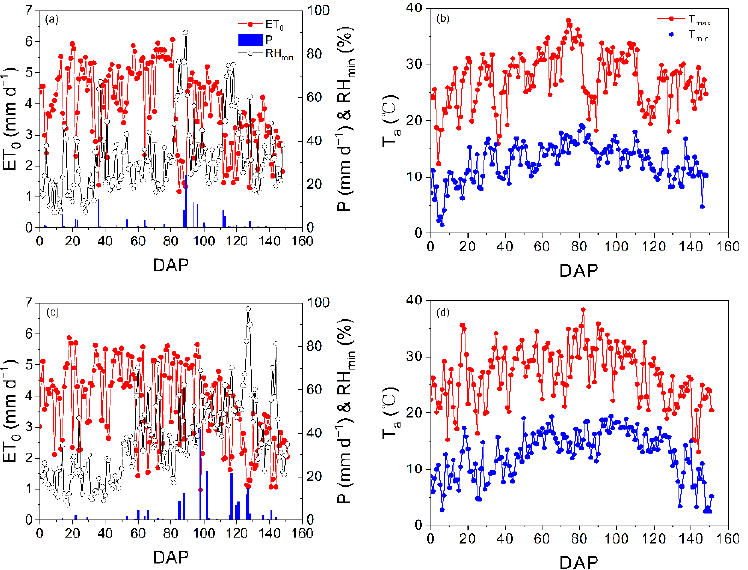
Figure 2. Daily variations of reference evapotranspiration (ET 0 ), precipitation (P), daily minimum relative humidity (RH min ), and maximum and minimum air temperature (T max and T min ) with days after planting (DAP) during the whole growth period of maize in 2017 ( a , b ) and 2018 ( c , d ).